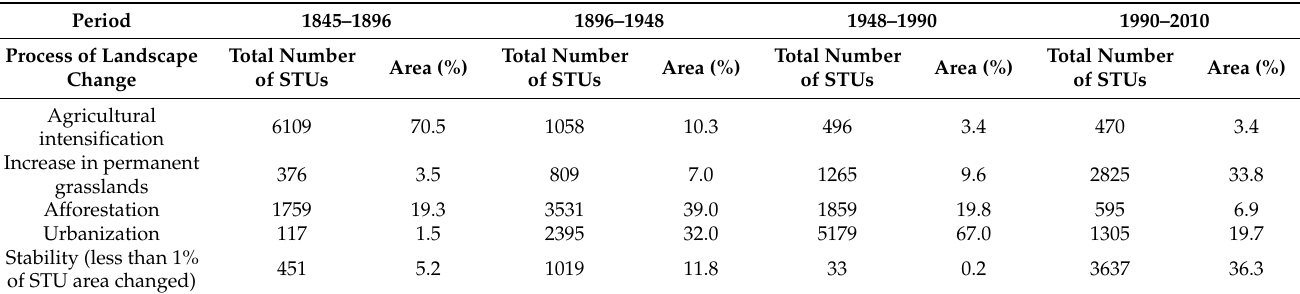
Figure 2. Major processes and intensity of landscape change between 1845 and 1896. Table 2. Major processes of landscape change in Czechia during